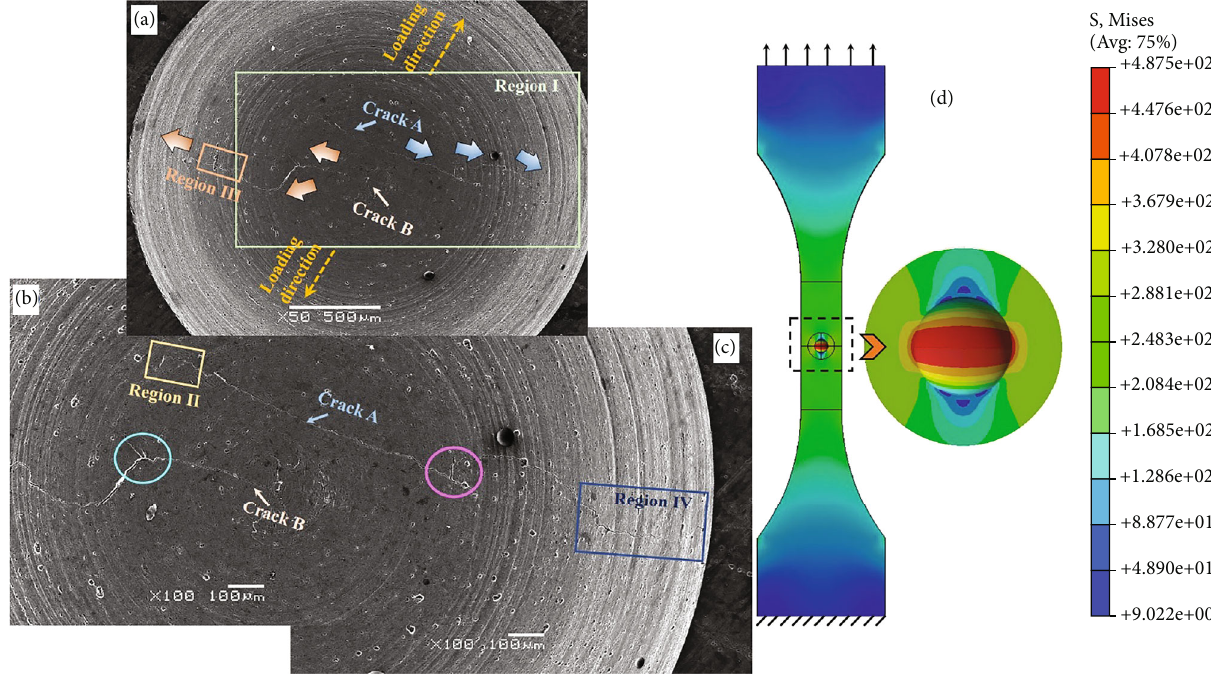
Figure 6: SEM micrographs of fatigue cracks: (a) overview of cracks; (b, c) 100x magni fi cation of region I in (a); (d) stress distribution in the hole of FEM